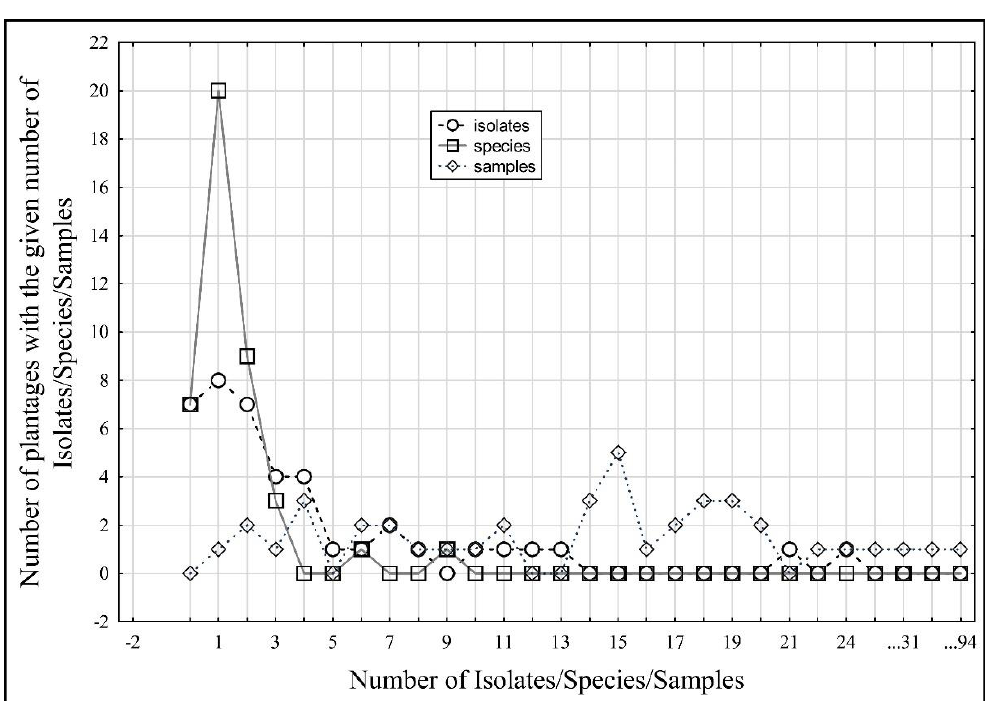
Figure 1. The correlation between numbers of sampled plants, numbers of isolates of Peronosporales and numbers of species of Peronosporales isolated from symptomatic strawberry plants on the farms in the Czech Republic. Table 4. Spearman correlation coefficient r expressing the correlation between the numbers of iso- lates, species, and sampled plants in strawberry farms.